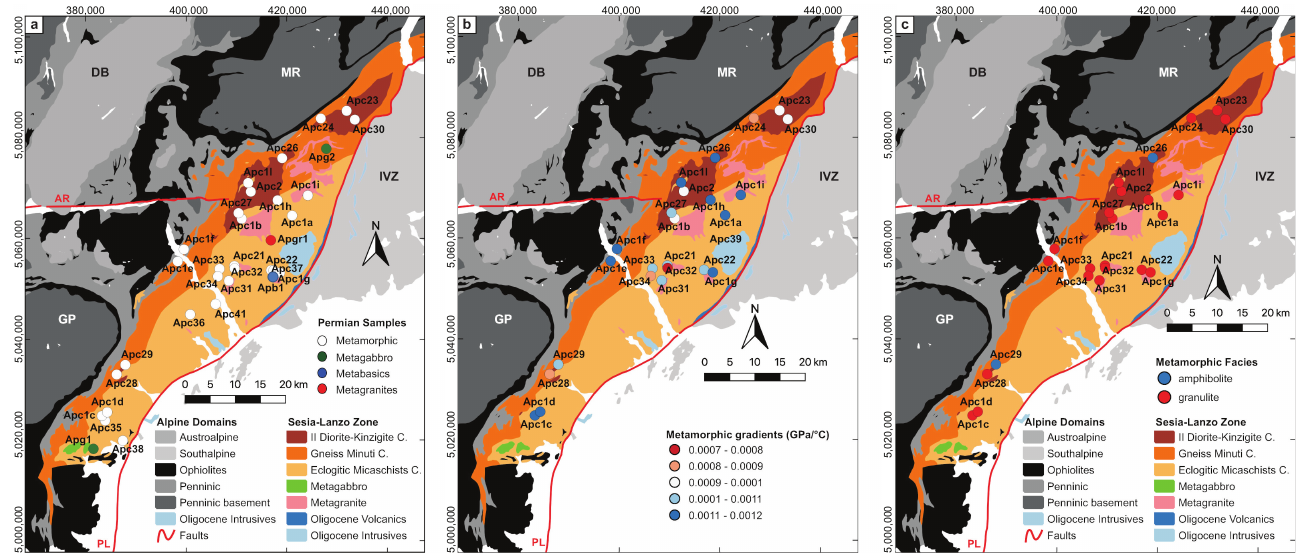
Figure 2. ( a ) Location of Permian metamorphic samples (white dots) and metagabbros (green dots) in the Sesia-Lanzo Zone. ( b ) Metamorphic states (P/T ratio) obtained from Permian metamorphic samples in the Sesia-Lanzo Zone. ( c ) Meta- morphic facies conditions of Permian metamorphic samples in the Sesia-Lanzo Zone. Sample code, geographical loca- tion, tectonic unit, lithology, pre-Alpine mineral assemblage, PT estimate, ages (where present), and references are in Table 1. DB = Dent-Blanche nappe; GP = Gran Paradiso Massif; MR = Monte Rosa Massif, IVZ = Ivrea-Verbano Zone; PL = Periadriatic lineament; AR = Aosta-Ranzola fault. Figure modified after [85]. Coordinate system WGS84-UTM